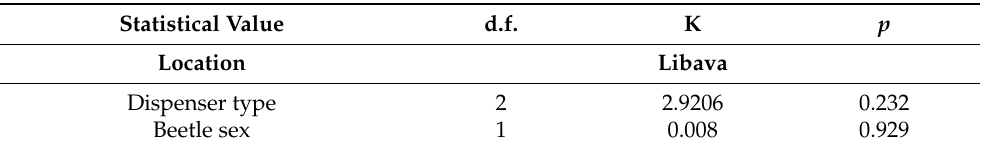
Table 5. Statistical analysis of differences between Ips duplicatus captures depending on dispenser type and beetle sex (Kruskal-Wallis: p < 0.05).